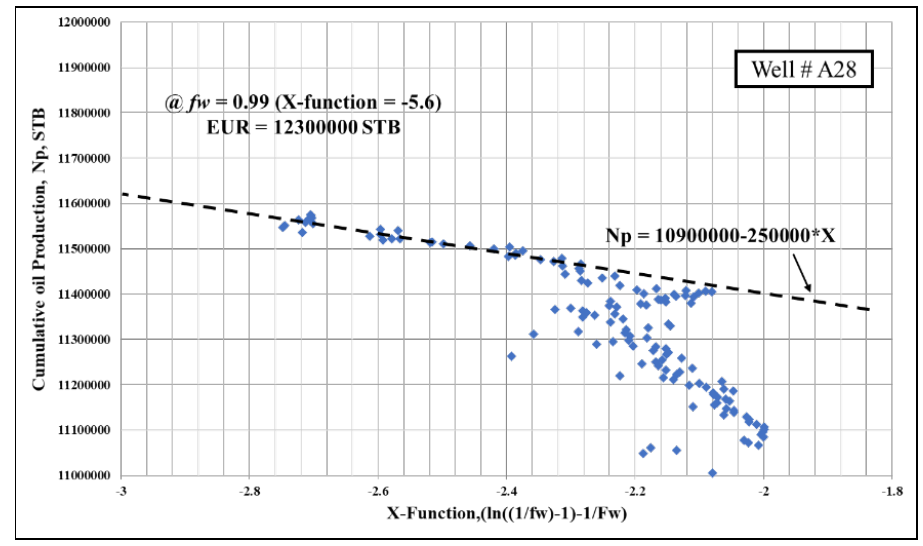
Figure 22. X-plot for well A06